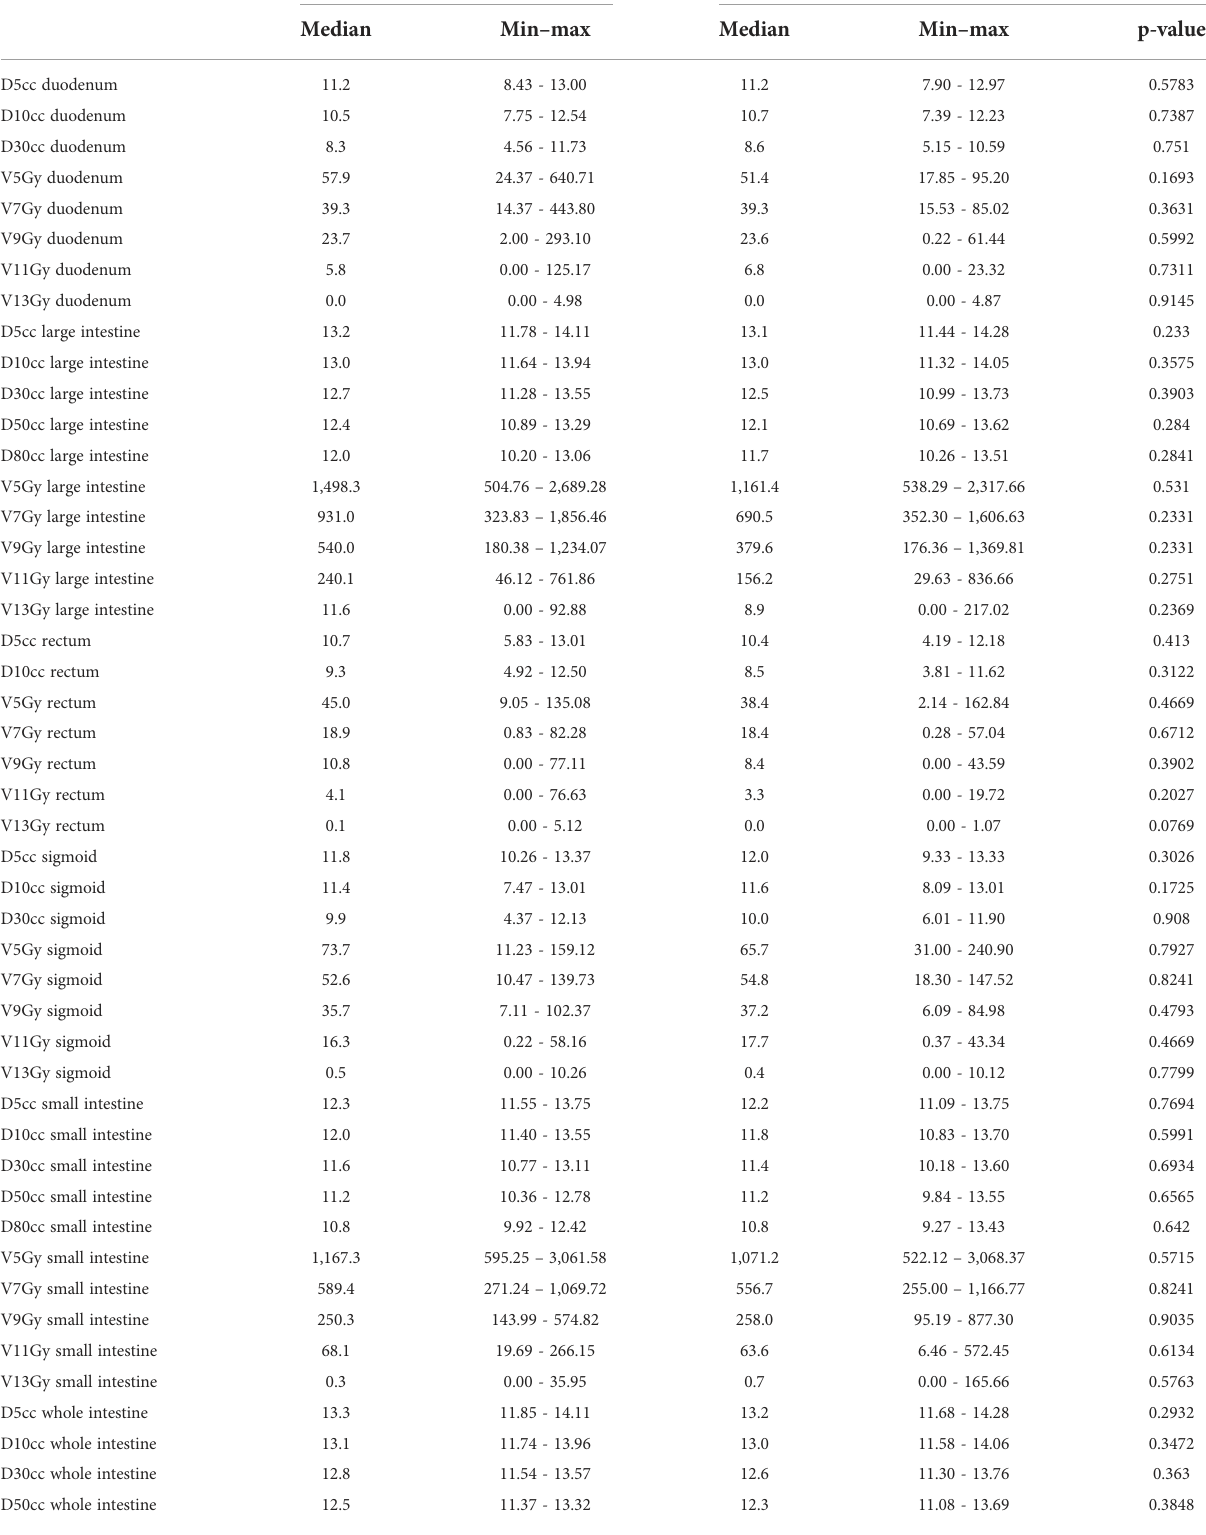
TABLE 4 Impact of dose delivered to the whole intestine and its segments on aGvHD. Dosimetric